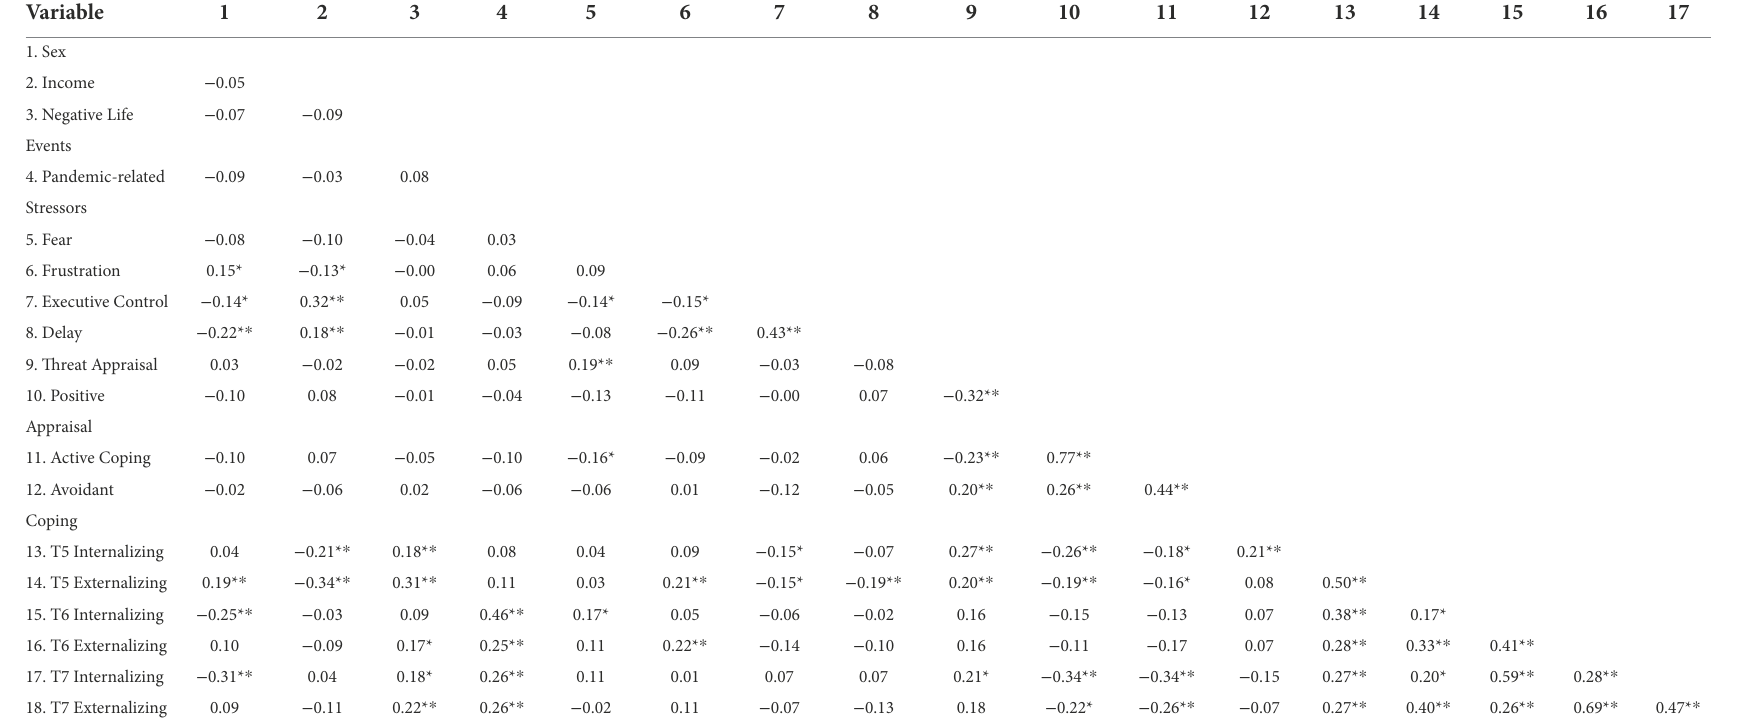
TABLE 2 Correlations among study